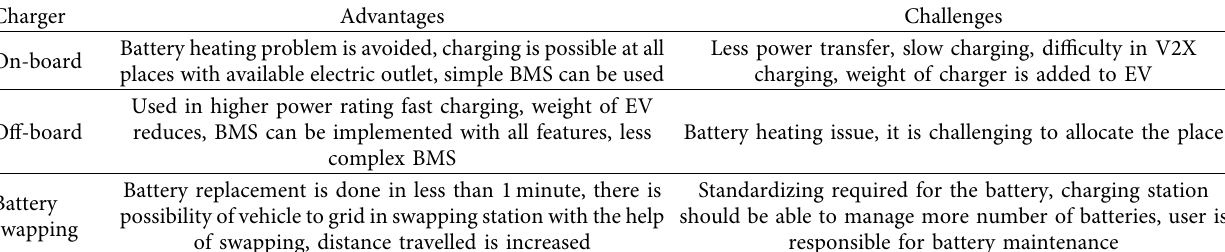
Figure 22: On-board and off-board chargers. Table 4: Advantages and limitations of types of charging [11, 144].